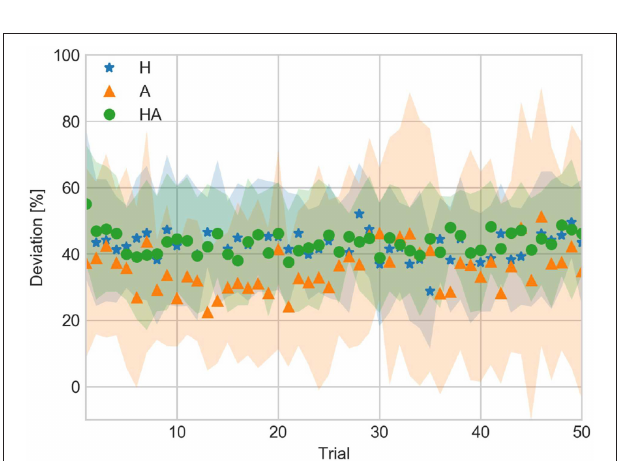
FIGURE 8 | Percentage of time to peak velocity against trial number averaged over all subjects for the haptic (H), acoustic (A), and haptic-acoustic (HA) conditions. The contour represents the standard